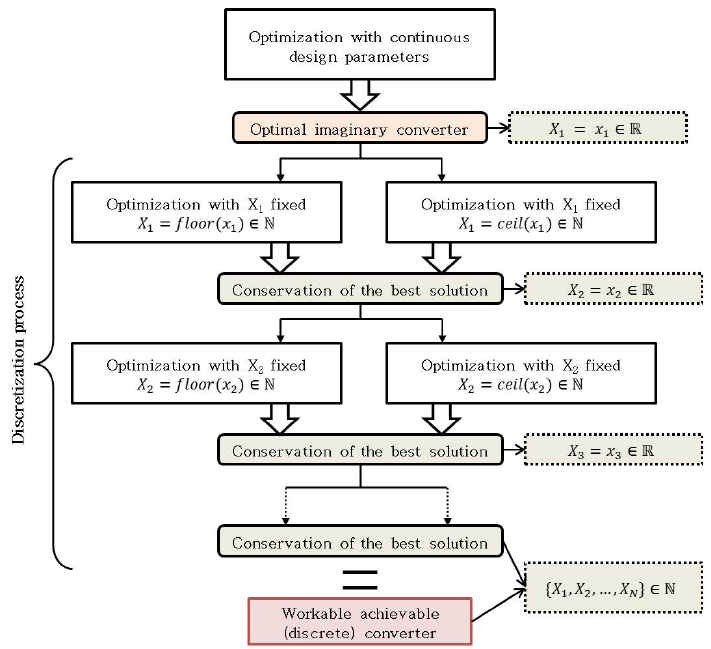
Figure 19. Proposed discretization process to come back in the real world.